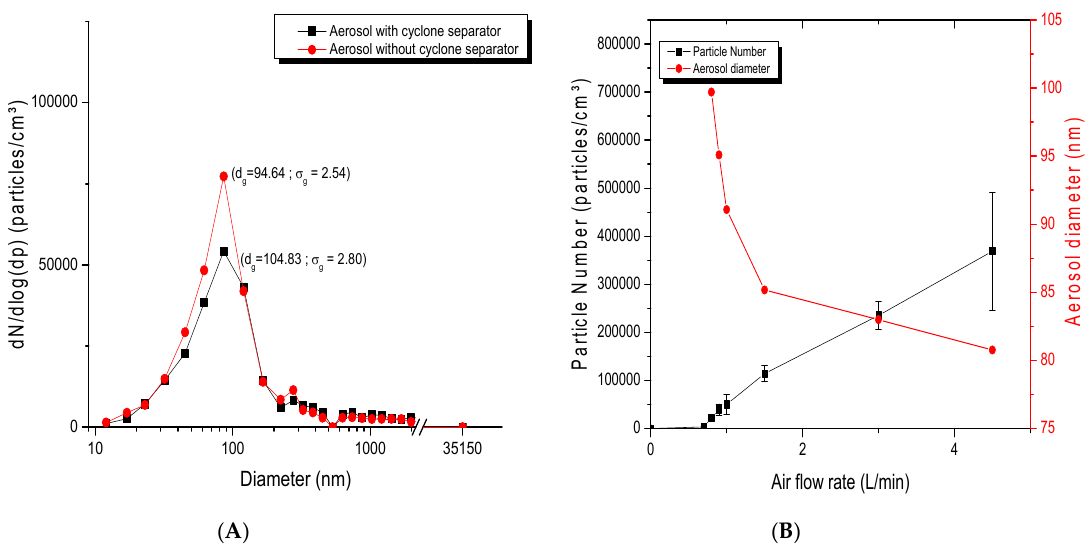
Figure 6. Parameters influencing dust jet aerosol generation: ( A ) size distribution of TiO 2 aerosol with the use of a cyclone airflow separator. TiO 2 nanopowders of 20 nm were used at an airflow rate of 5 L/min. ; ( B ) average diameter and number of particles of TiO 2 (20 nm) in the aerosols generated as function of airflow rate.